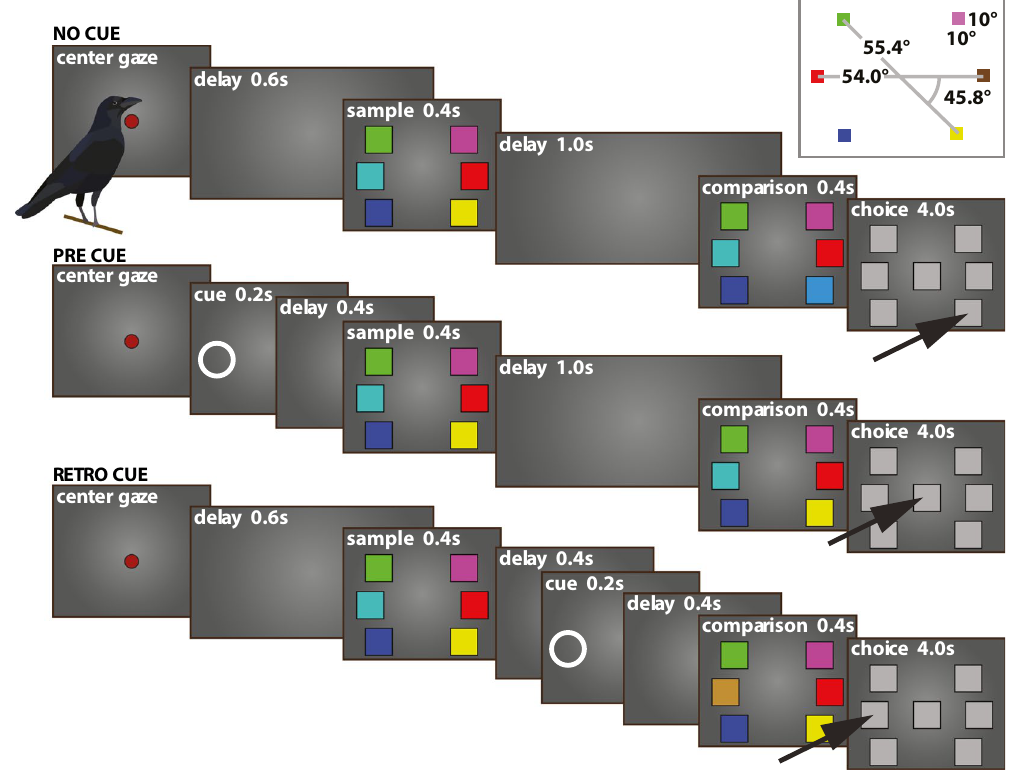
Figure 1. Behavioral protocol: The change detection task. Following the presentation of a red dot in the center of the screen the crows had to hold the head straight and centered to start the trial. They had to maintain this head-position until the choice period at the end of the trial. Each training session consisted of no-cue, pre-cue and retro-cue conditions. The overall duration of the conditions was matched. In all conditions the animals viewed an array of 2, 4 or 6 colored squares for 0.4 s. After a memory delay of 1.0 s the array re-appeared for 0.4 s. On 50% of the trials one color was exchanged and the animals had to indicate during the choice period if any color was changed in the new array. A peck to the center indicated no change while a peck on any of the peripheral stimuli indicated change. In the pre- and retro-cue conditions an additional stimulus was presented to cue the location at which the color-change would occur. If no change occurred the cue-location was chosen at random. On pre-cue trials the cue was presented before the sample-array while on retro-cue trials it was presented following the sample-array during the